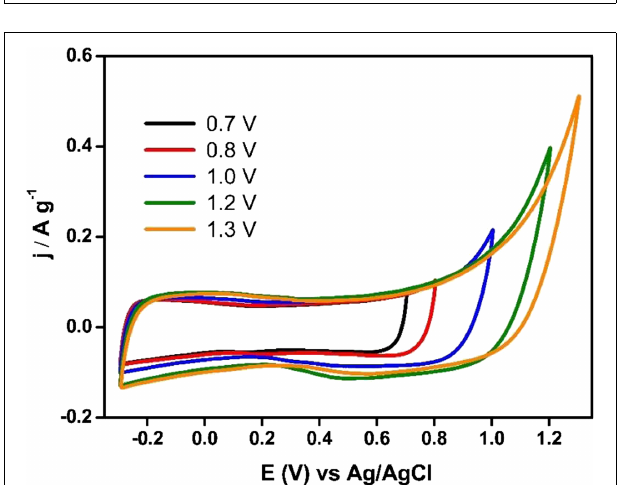
FIGURE 6 | Steady voltammograms of ACM toward positive potentials ( υυυ = 1mVs (cid:0) 1 ; 0.5M Na 2 SO 4 ) .